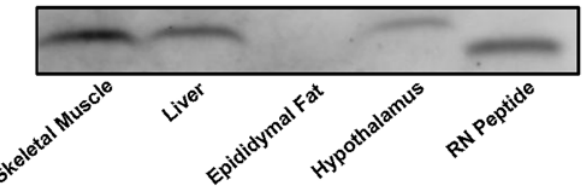
Figure 1. Protein level of the rat homolog to HN, termed rattin (RN), in metabolically-relevant tissues in male S–D rats. A total of 30 m g of rat skeletal muscle (lane 1), liver (lane 2), epididymal fat (lane 3) and hypothalamic protein (lane 4) and 1.5 ng of synthetic RN peptide (lane 5) were loaded. RN protein was detected in muscle, liver and hypothalamus but not in epididymal fat (lane